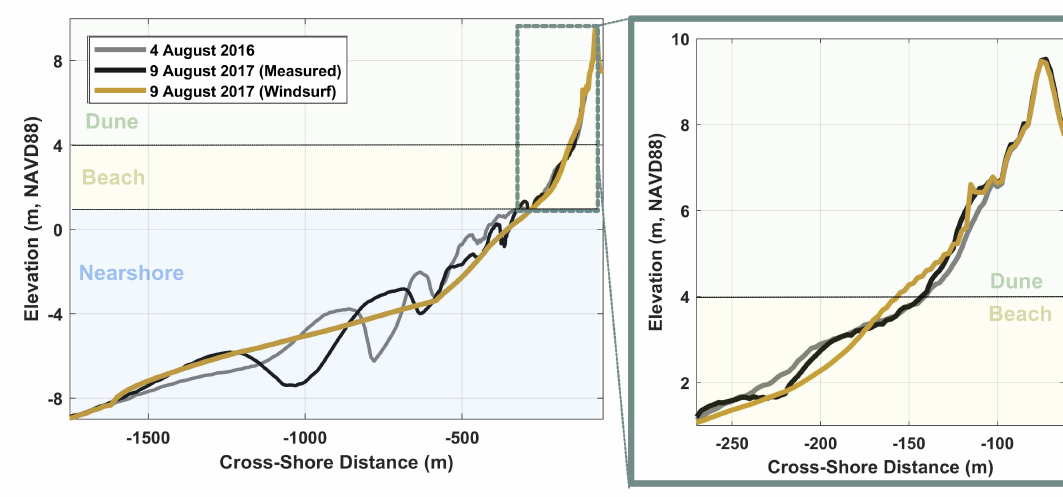
Figure 4. Measurements of coastal profile change of the nearshore, beach, and dune over a 1-year period between August 2016 (grey line) to August 2017 (black line). The calibrated Windsurf model prediction after one year is shown in